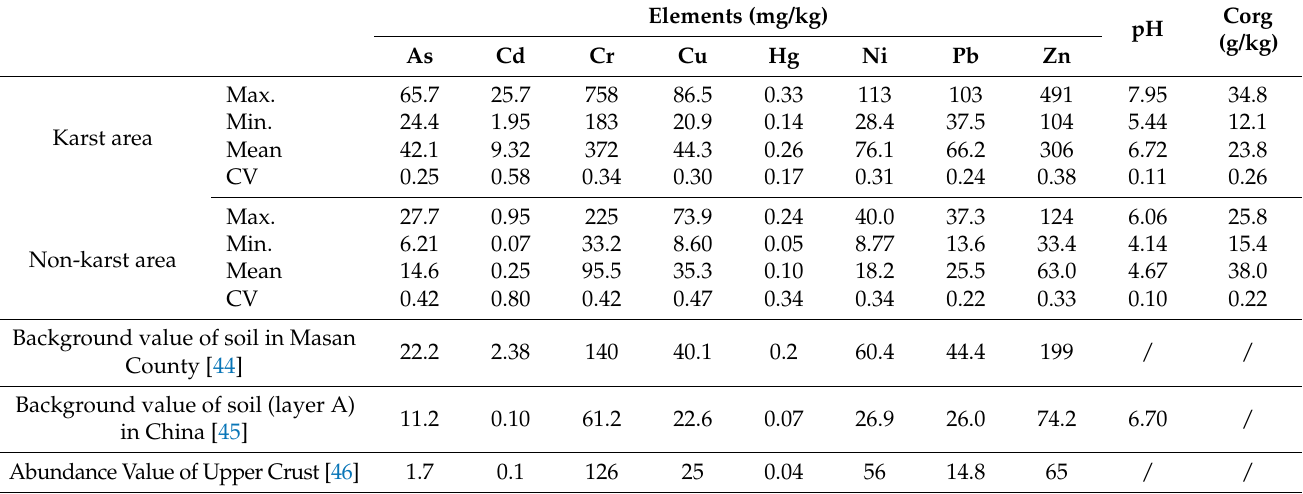
Table 2. Characteristics of heavy metal content in surface soil of study